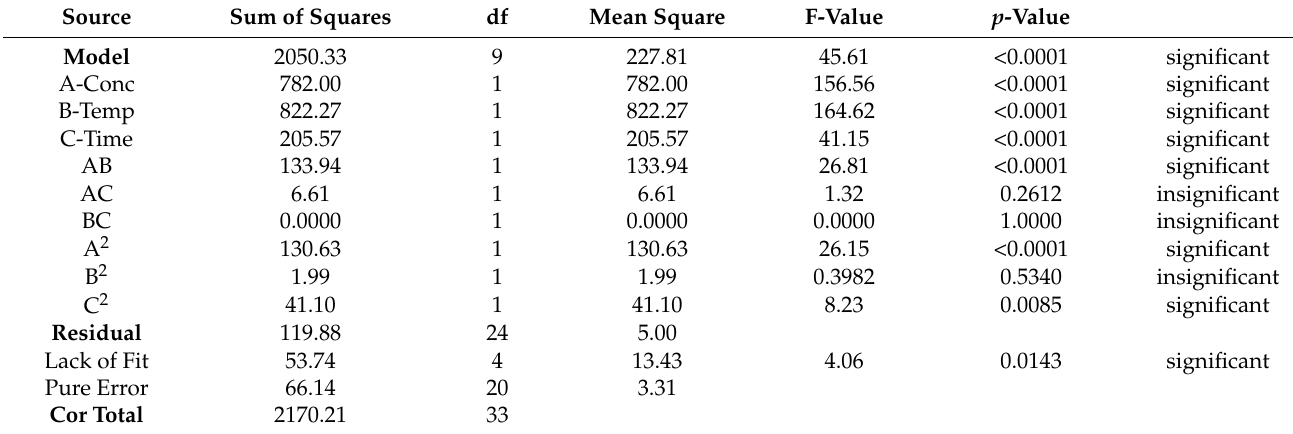
Table 10. ANOVA for Tb